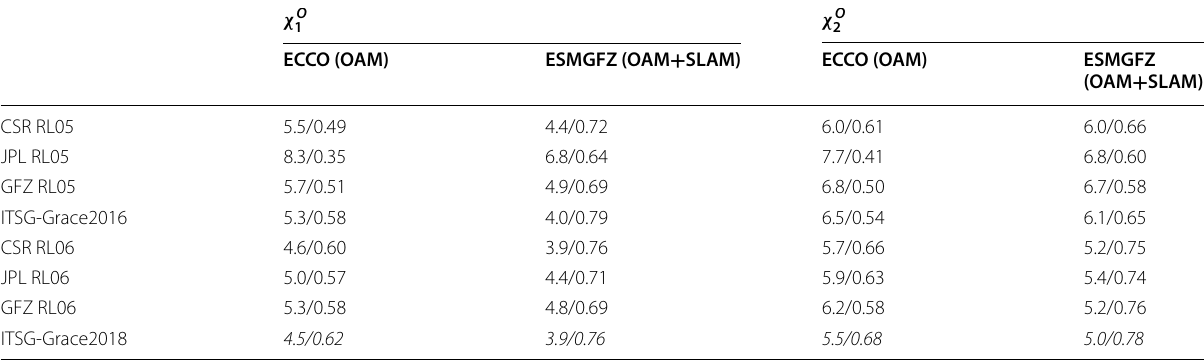
Trends have been removed prior to the determination of the RMS differences and correlation coefficients The smallest RMS differences and largest correlation coefficients of all GRACE solutions are marked in